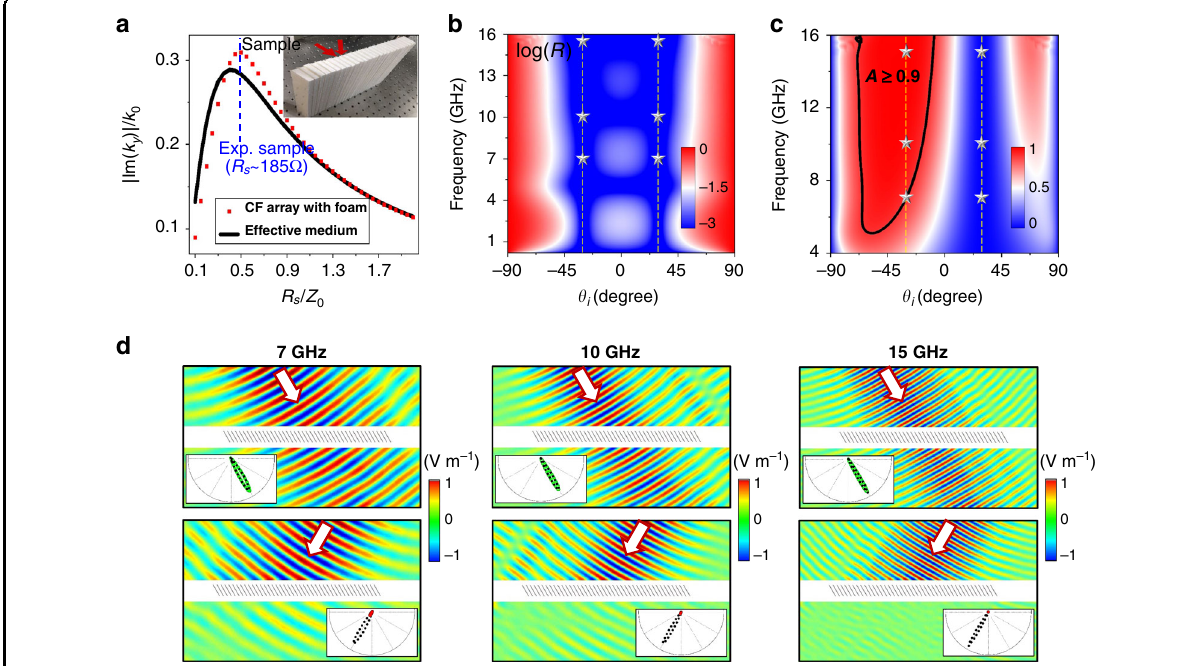
(cid:5) (cid:3) (cid:4)(cid:5) (cid:5) (cid:5) in the CF array